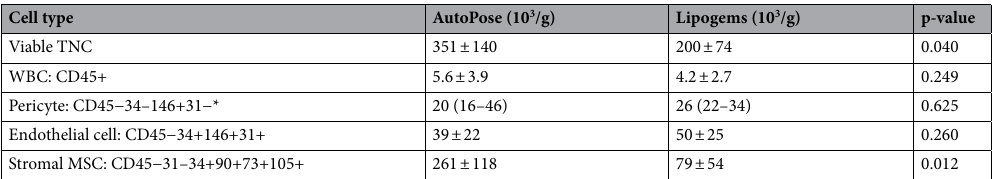
Table 3. Number of cells normalized per gram of enzymatically digested product 3 days after culture (10 3 /g). Aggregate mean and standard deviation (SD) of data represented as “mean ± SD”. *Data set not normally distributed and represented as “median (interpercentile range)”.